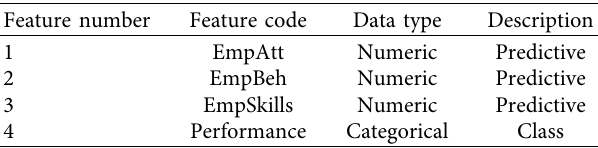
Table 4: Description of